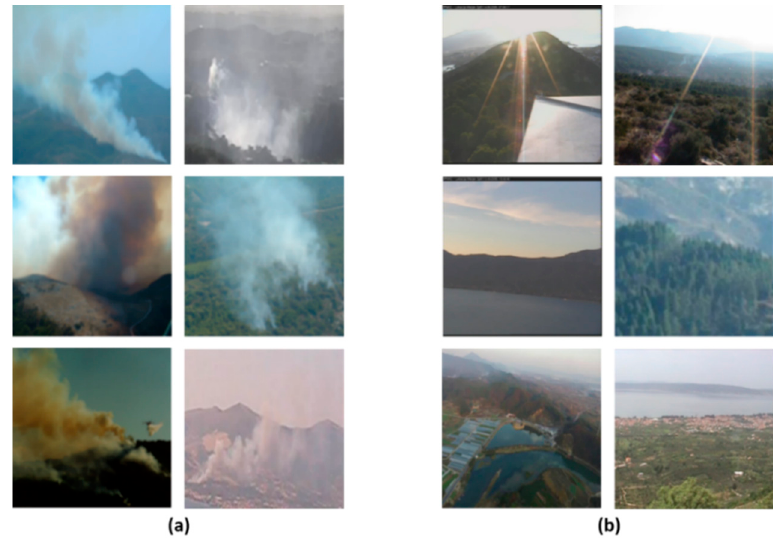
Figure 4. Samples of test images: ( a ) real smoke; ( b ) real non ‐ smoke.